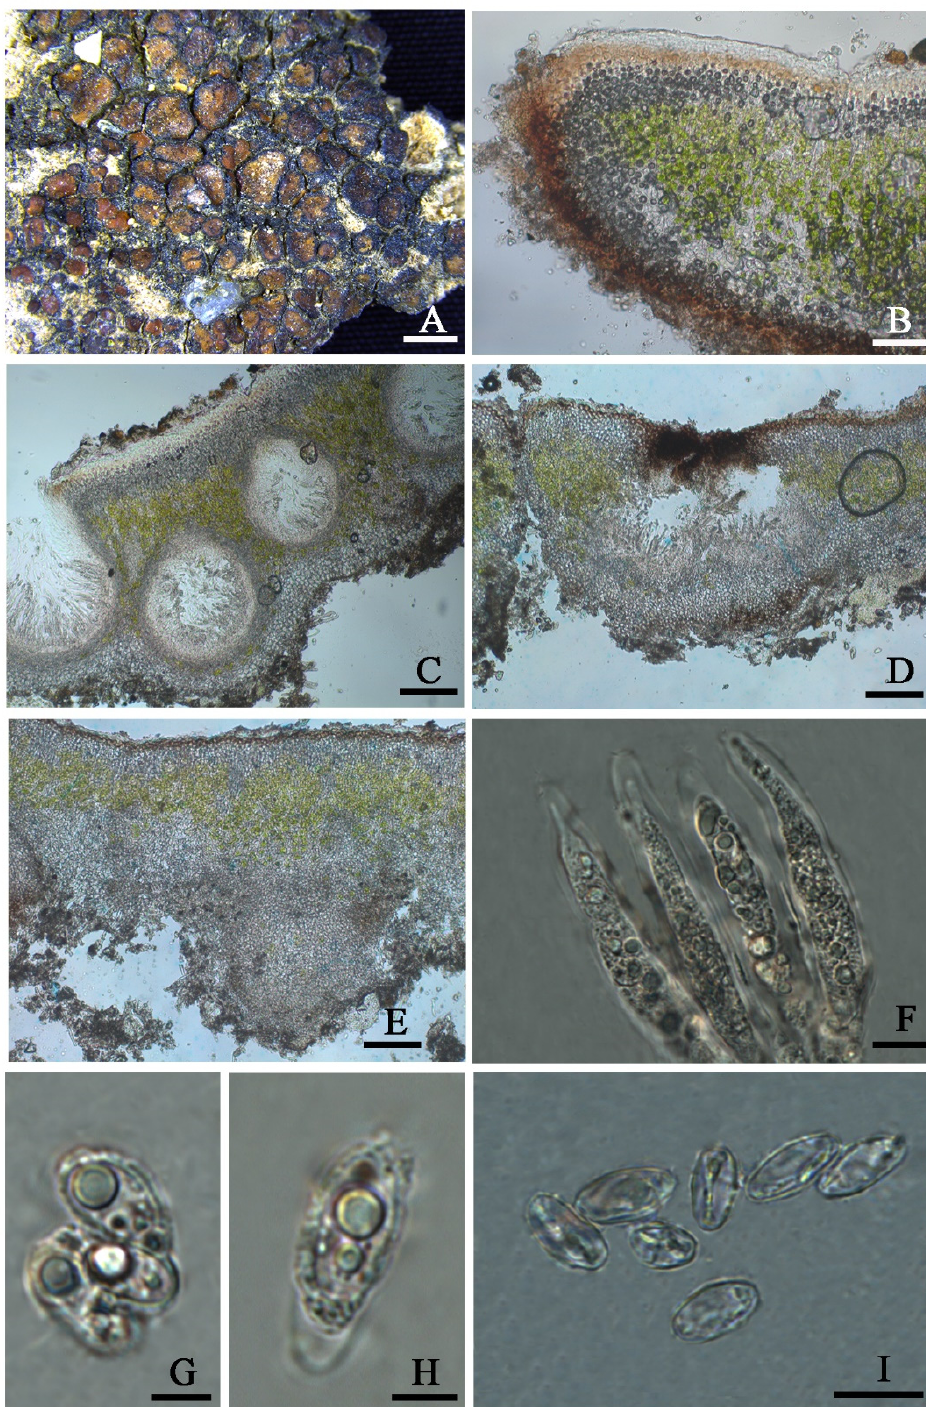
Figure 5. The thallus habit and the anatomic structure of Placidium nitidulum sp. nov (holotype HMAS-L 151947). ( A ). Squamulose thallus. ( B ). Transversal section of thallus. ( C ). Immersed perithecia. ( D ). Aggregated pyrithecia. ( E ). Pycnidium. ( F ). Cylindrical asci with uniseriate ascospores. ( G–I ). Ascospores. Bars: ( A ) =2 mm, ( B ) =50 µm, ( C–E ) =100 µm, ( F ) =10 µm, ( G , H ) =5 µm, and ( I ) =10 µm.